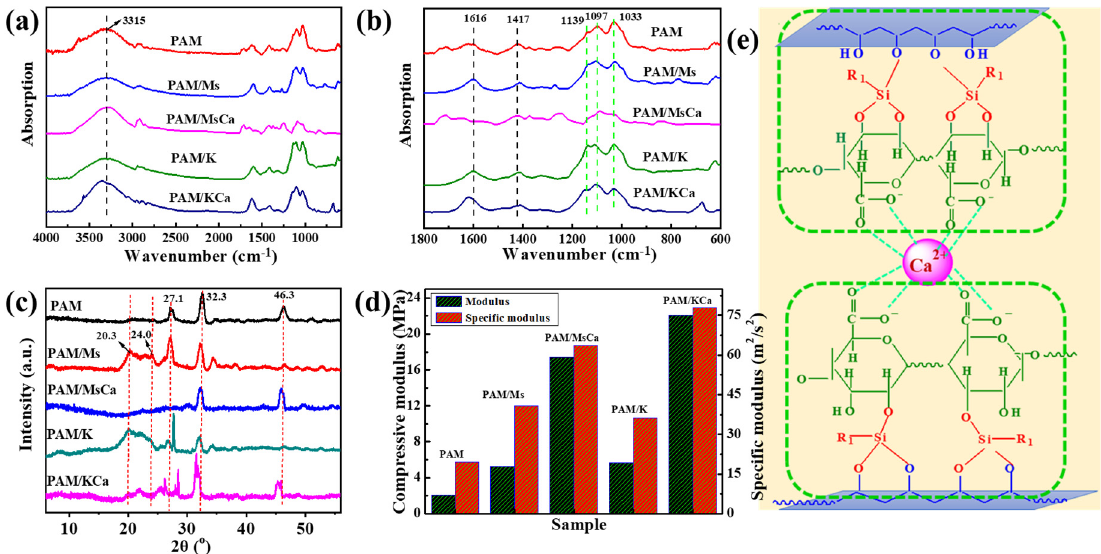
Figure 2. ( a ) FT-IR spectra and enlarged spectra of the different PAM composite aerogels in the range of 4000–600 cm − 1 , ( b ) 1800–600 cm − 1 ; ( c ) XRD patterns of the different PAM composite aerogels; ( d ) Compressive properties of the different PAM composite aerogels. ( e ) Schematic diagram of inter- penetrating cross-linking (IPN) network mechanism of PAM aerogels with silane and